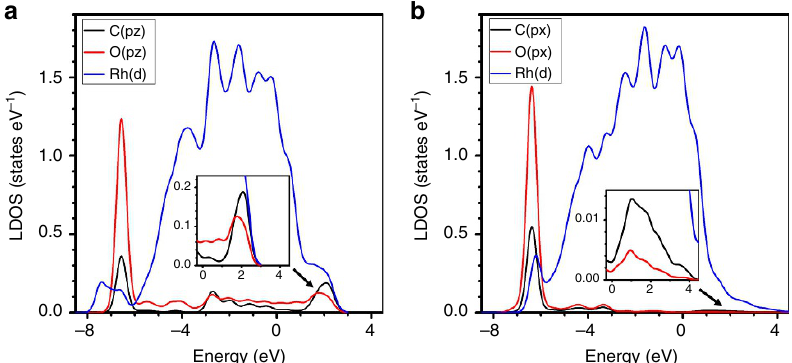
Figure 4 | DFTcalculations of CHO and CO intermediates on the Rh(100) surface. ( a ) LDOS for adsorbed CHO on C( p z ), O( p z ), and Rh( d ) orbitals. The Rh(100) surface is perpendicular to the x direction, and the C–O bond is along the y direction. Major bands are identified as: (1) C–O p bonding band ( (cid:2) 6.5eV) with C( p z ) (black) and O( p z ) (red) interactions; (2) C–O p * anti-bonding band (1-3eV, mode around 2eV) with C( p z ) and O( p z ) interactions. ( b ) LDOS for adsorbed CO on C( p x ), O( p x ), and Rh( d ) orbitals. The Rh(100) surface is perpendicular to the x direction, and the C–O bond is along the x direction. Major bands are identified as: (1) C–O s bonding band ( (cid:2) 6.3eV) with C( p x ) (black) and O( p x ) (red) interactions; (2) Very weak Rh–C anti- bonding band (0–3eV, mode around 1eV) with C( p x ) and Rh( d ) (blue) interactions. The structures of the models used for calculations are given in Supplementary Fig. 7. All energies are referenced to the Fermi level. The insets are magnified plots of the anti-bonding